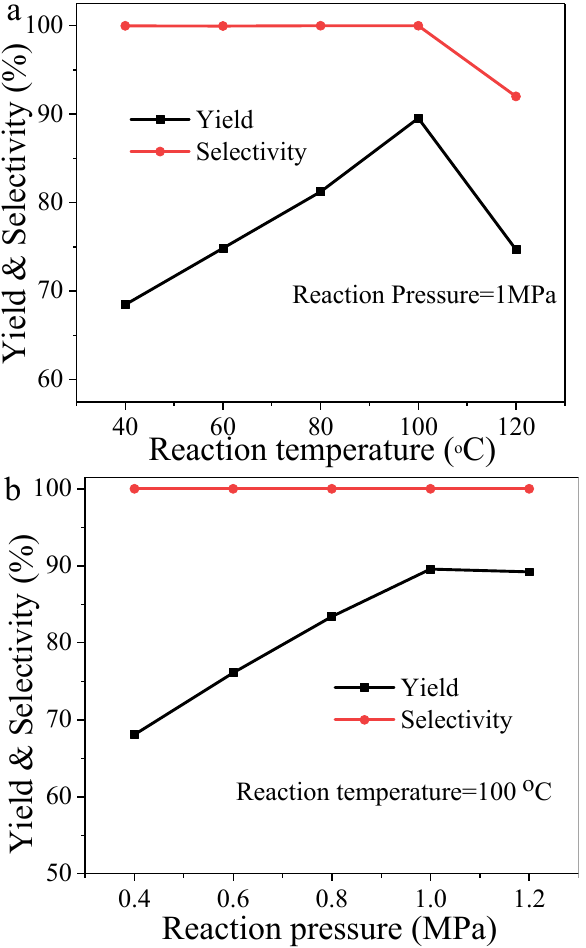
Figure 13. Effect of ( a ) reaction temperature and ( b ) pressure on the yield and selectivity of MP.